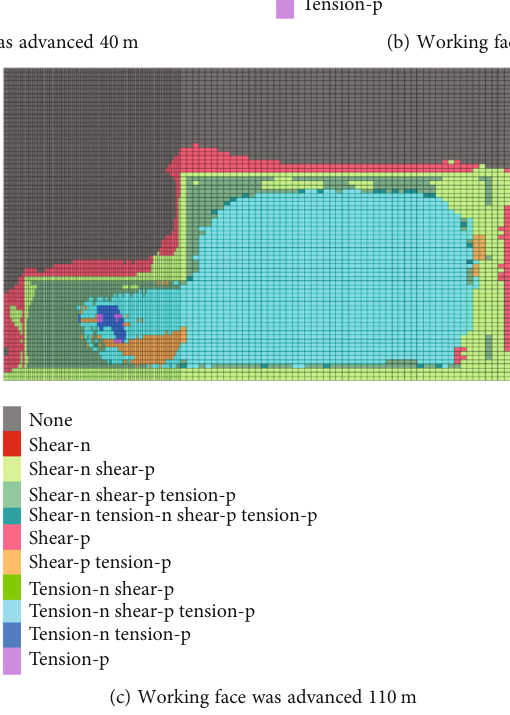
Figure 29: Development of plastic zone in large mining